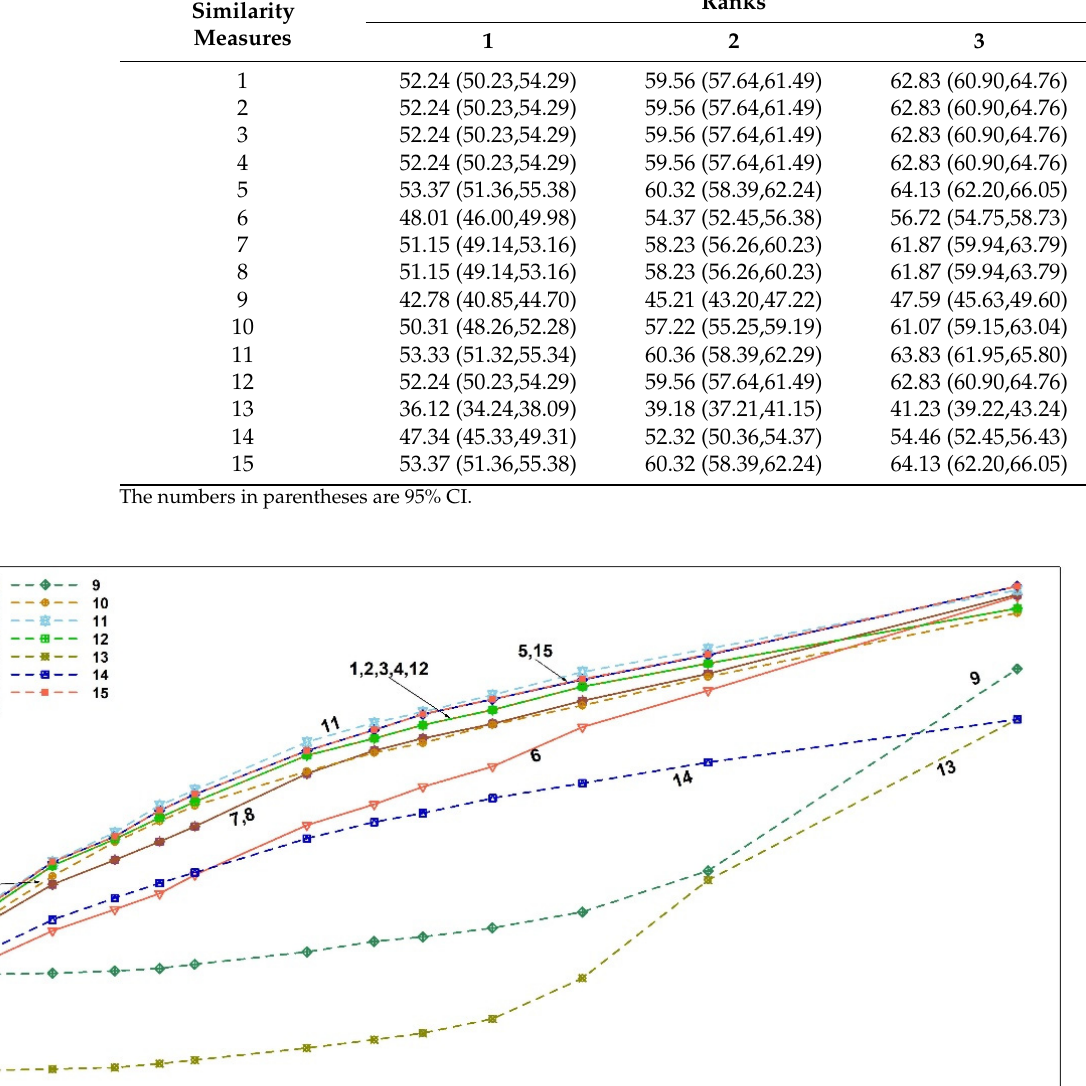
Table 2. Accuracy and 95% CI of all 15 binary similarity measures for ESI mass spectra-based compound identification up to top three highest similarity scores.